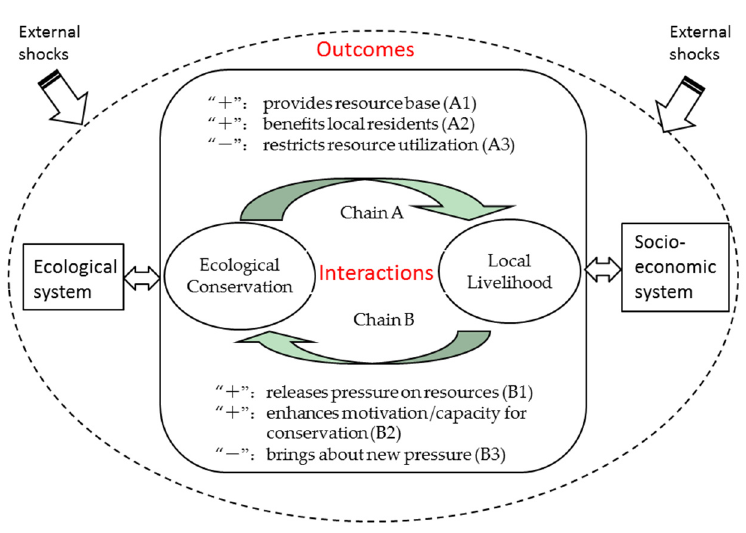
Figure 1. Interactions between ecological conservation and local livelihood.